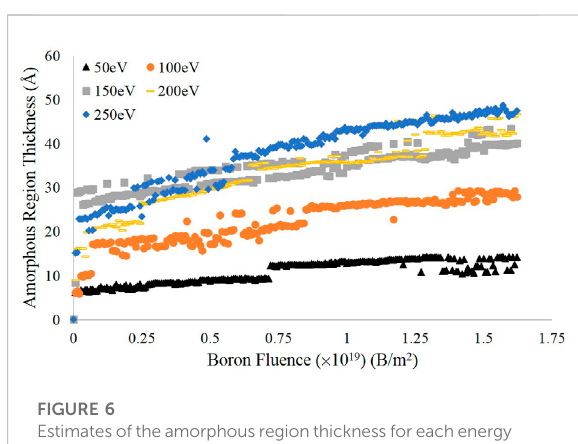
FIGURE 6 Estimatesoftheamorphousregionthicknessforeachenergy tested, calculated using the difference between the surface height estimate and the interface height value determined from deviations in the coordination